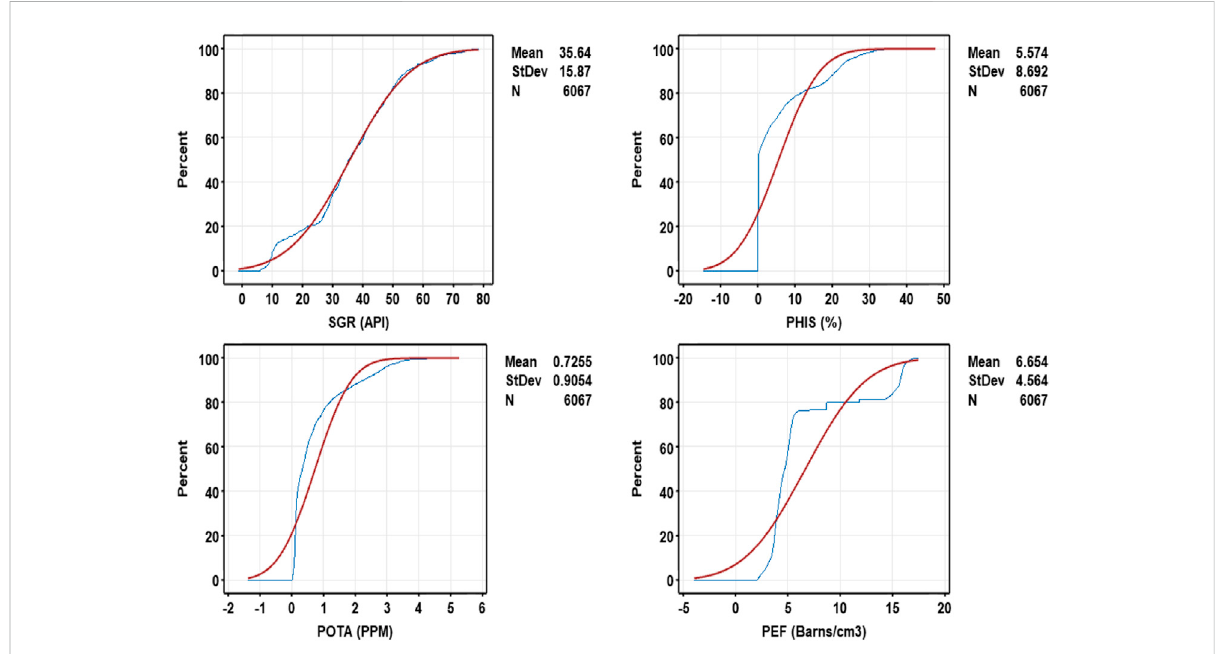
FIGURE 9 Schematicofthecumulativedistributionfunction(CDF)todescriptionfourinputvariablesdataset.Thevariableis:SGR;PHIS;POTA;PEF.Inthis fi gure, the blue and red line an input variable and standard deviation